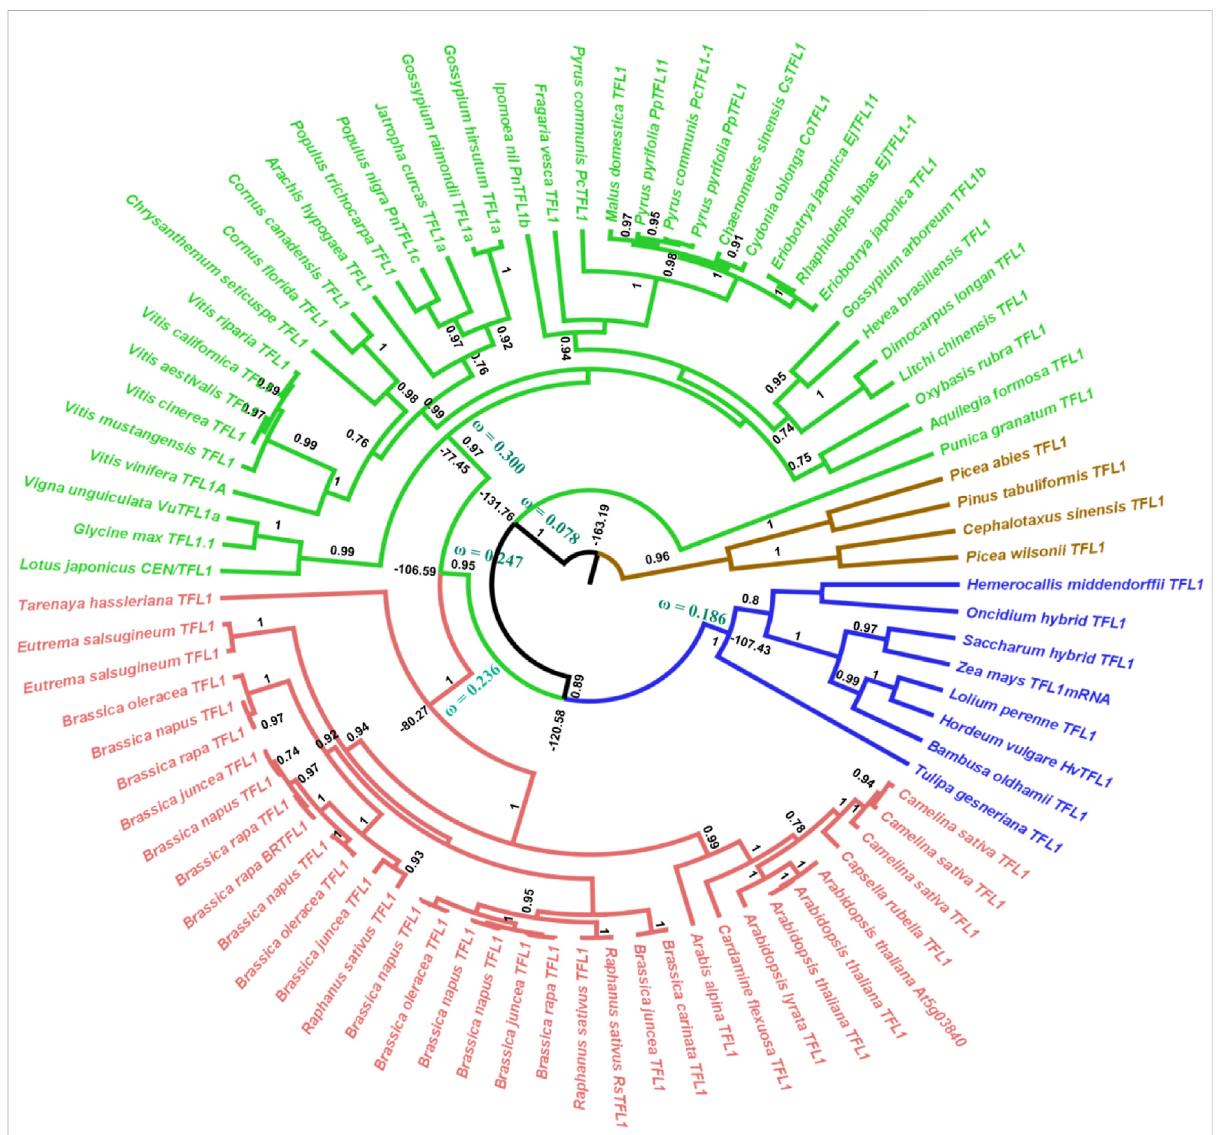
FIGURE 2 Bayesian phylogenyofangiosperm TFL1 sequences. The major branchesare indicatedby posteriorprobability. Molecular datingand thedN/dS ratios represented by the ω value are observed in the major clades. Colors indicate the clades, red = brassicales, green = non-brassicales, blue = monocots, brown = outgroup. The brassicales and non-brassicales clades (red and green) form the ancestor of